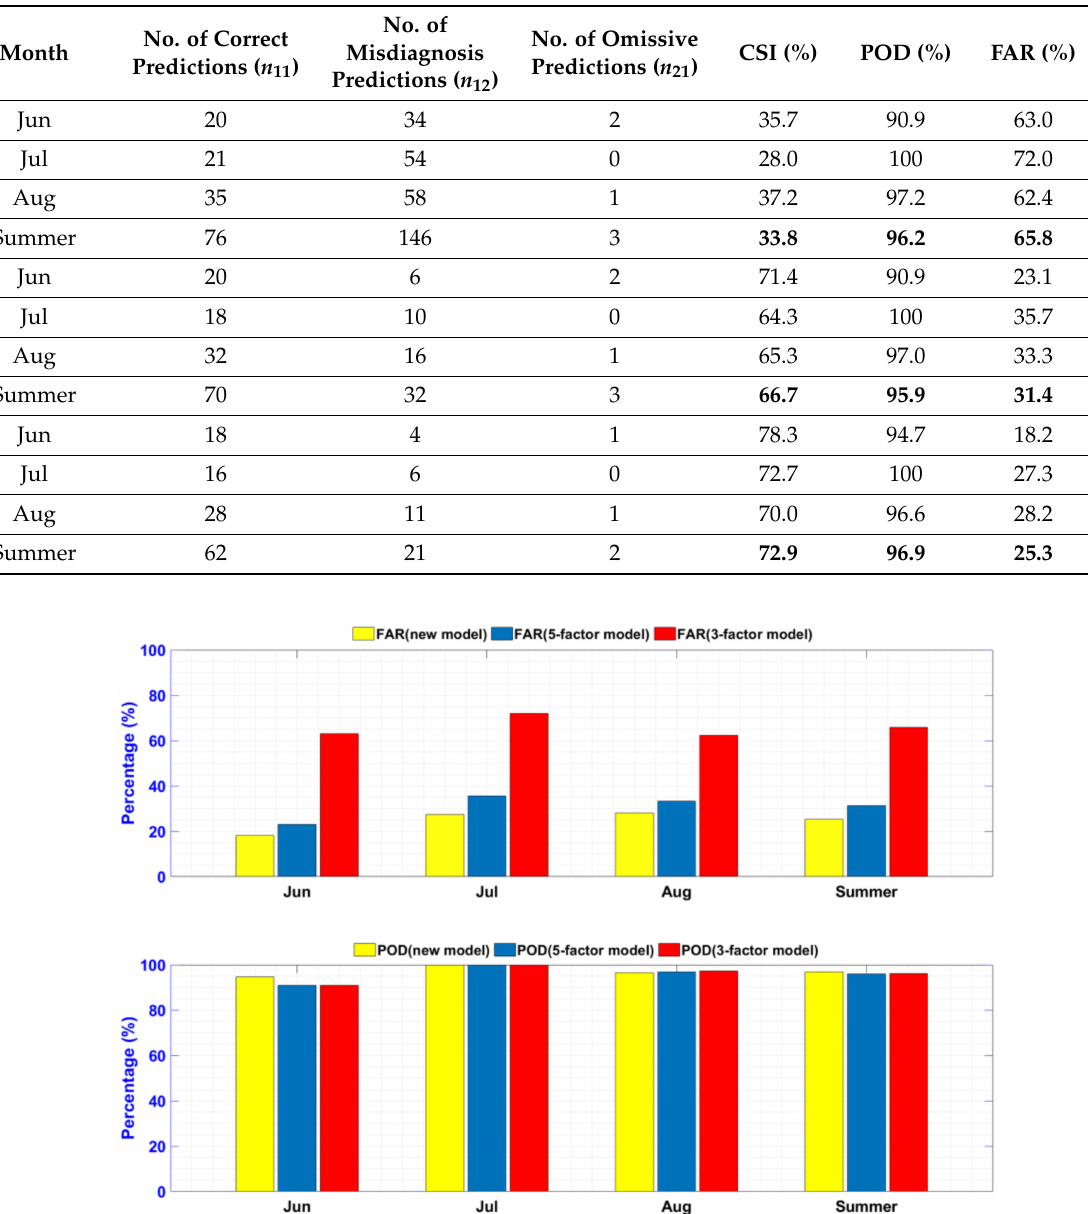
Table 2. Comparison of predictions resulting from the new model and the monthly models (five-factor model and three- factor model) for each summer month and summer season in the 2-year period of 2018–2019.